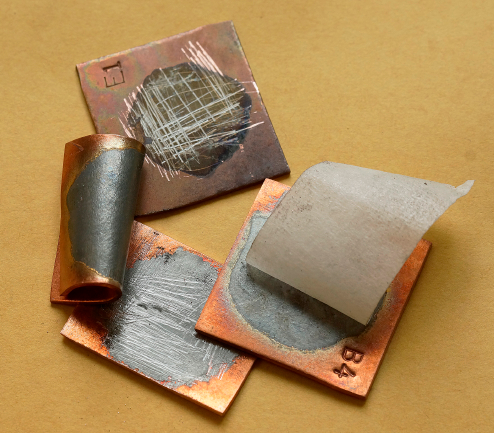
Figure 4 . Tests for adhesion of coatings. Figure 4. Tests for adhesion of